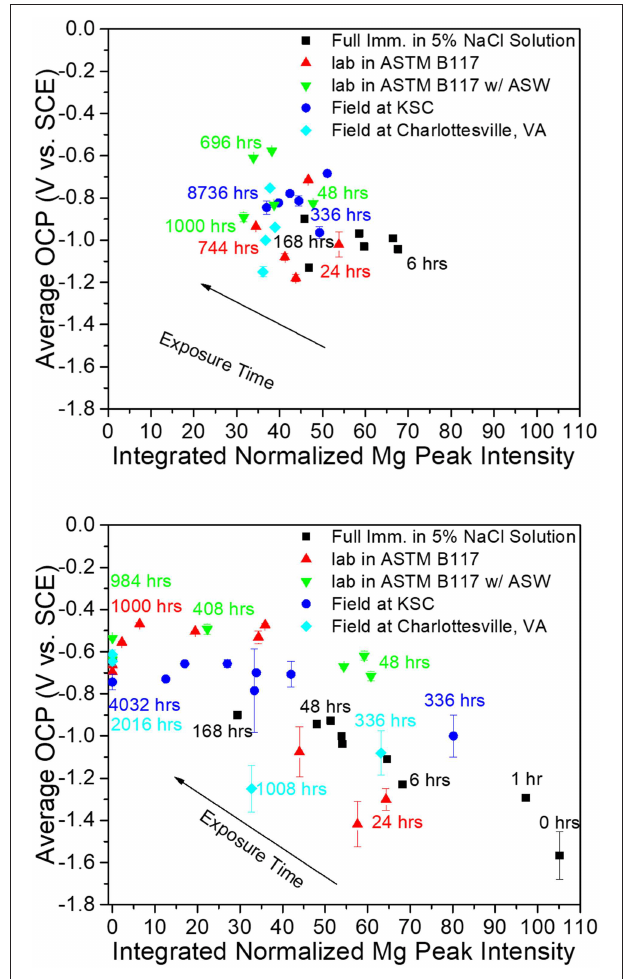
FIGURE 5 | Correlation between integrated Mg peak (Mg < 200 > 2 θ = 36.6170 degrees) intensity obtained from pigment vs. galvanic protection potential of AA2024-T351 coated with MgRP (initial MgPVC = 45%) (top) and MgRP + topcoat (bottom) in ambiently aerated 5% NaCl solution after exposure in various environments ( King et al., 2015). Reproduced with